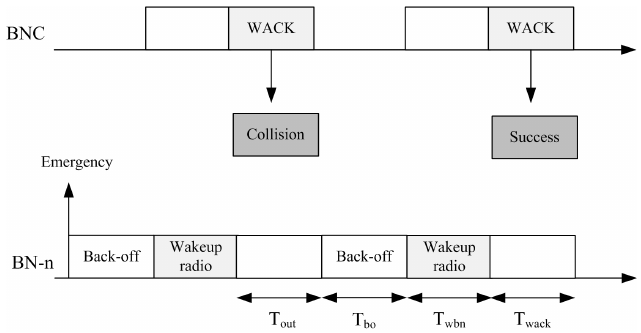
Figure 13. Example MAC operation using the wake up radio.